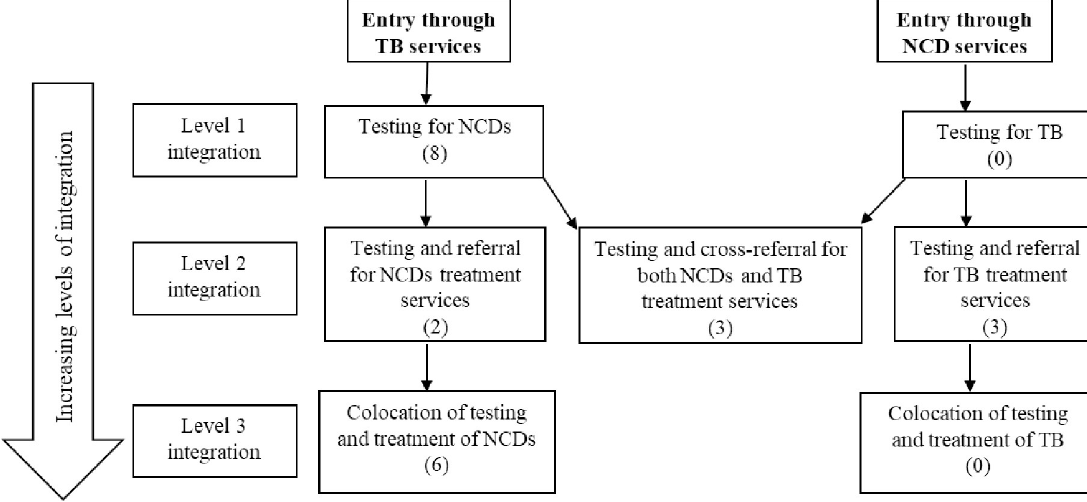
Fig 3. Framework for integration of TB and NCDs services. Illustrated summary of different models of integration using either TB or NCD as points of entry into the health system. Numbers in brackets represent the number of studies reporting the respective model of integration. NCD, noncommunicable disease; TB,